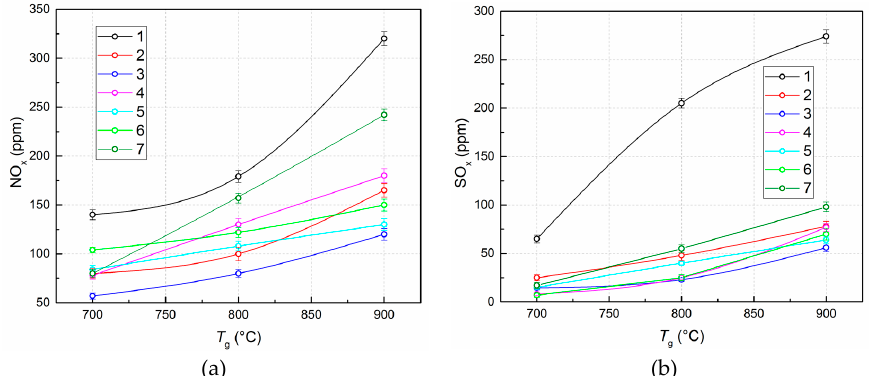
Figure 4. Concentration of nitrogen ( a ) and sulfur oxides ( b ) emissions of slurry fuels with biomass and coal vs. combustion chamber temperatures: 1%– 00% coal; 2%–90% filter cake and 10%